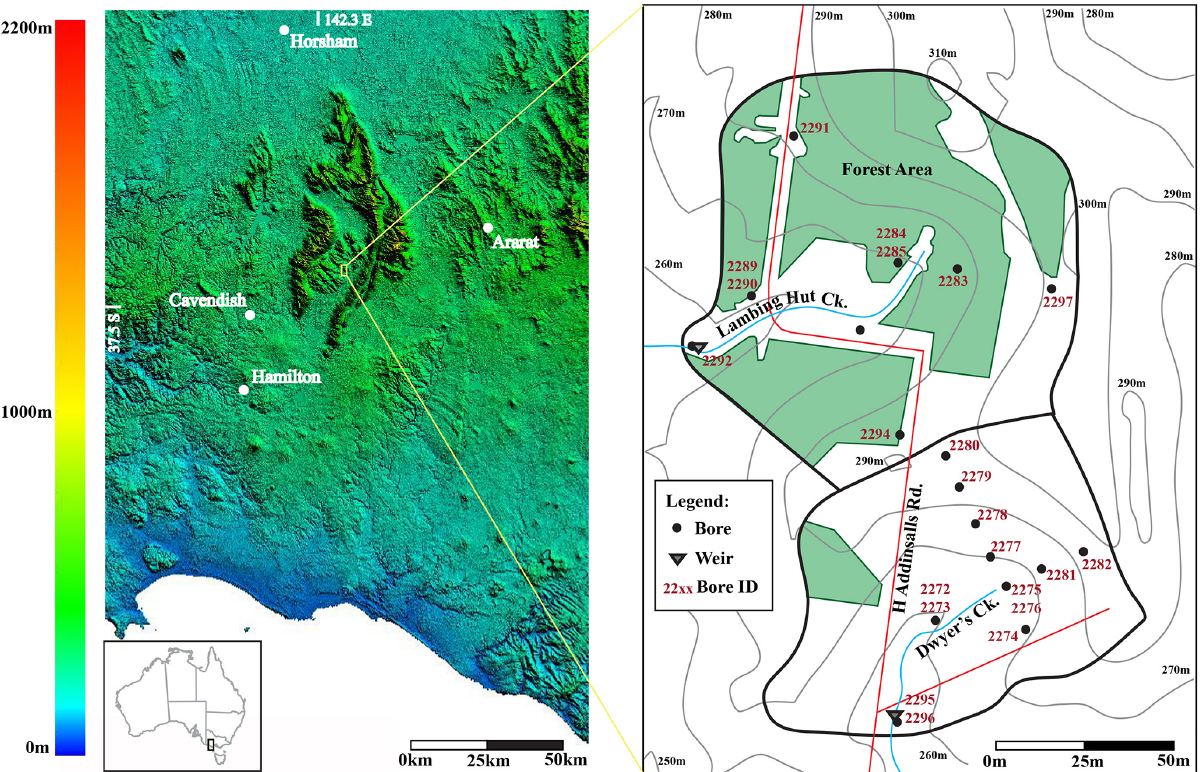
Figure 1. Left – Location of the study site in southwestern Victoria, Australia. Right – location of the bores, streams and weirs.